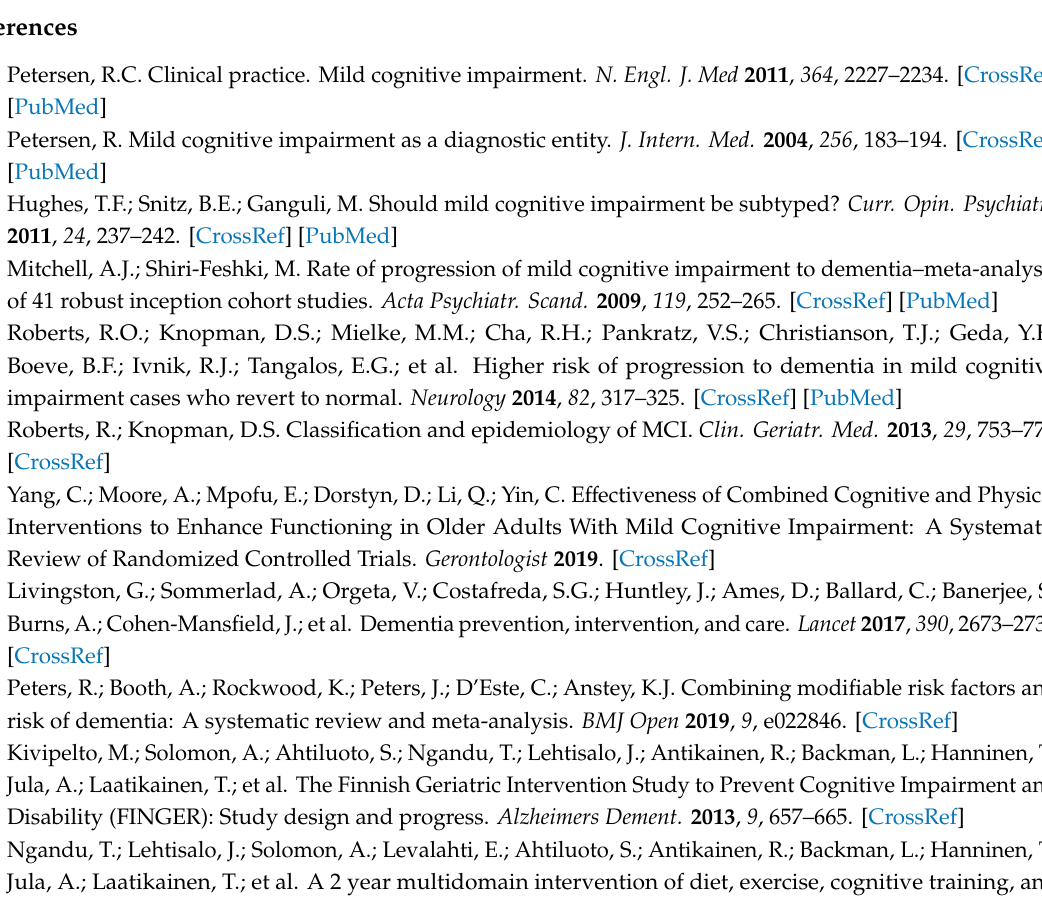
Table S1: Baseline characteristics in participants who remained versus left the follow up